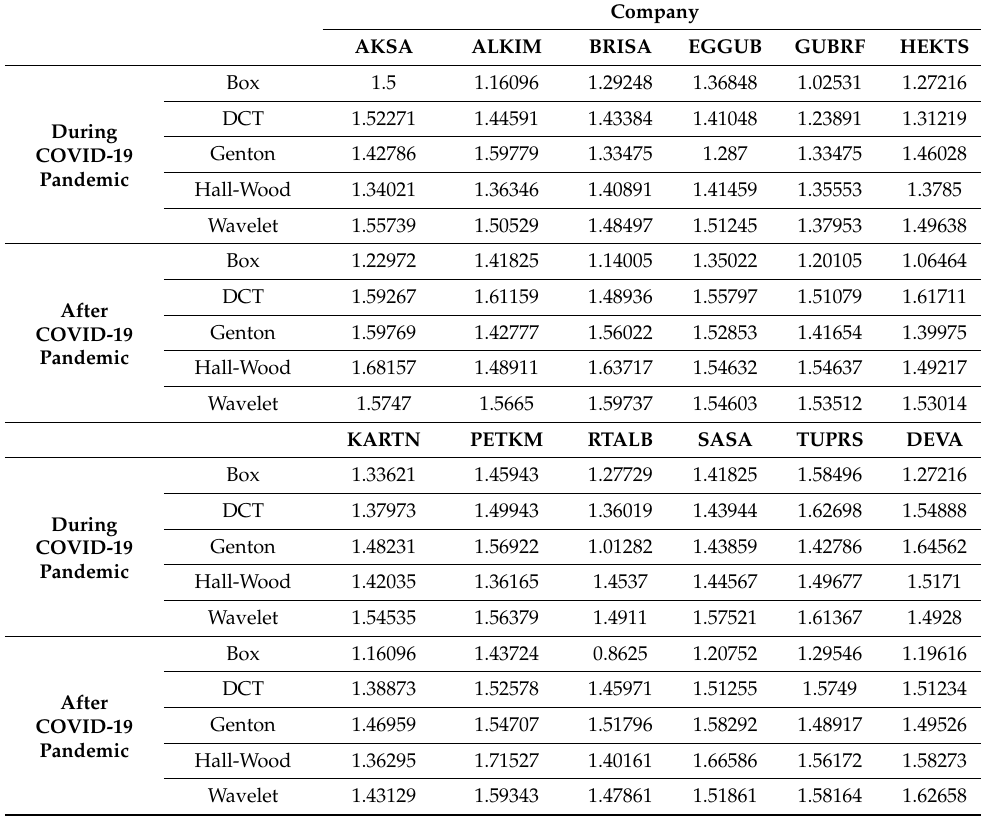
Table A6. Fractal dimensions for the chemicals